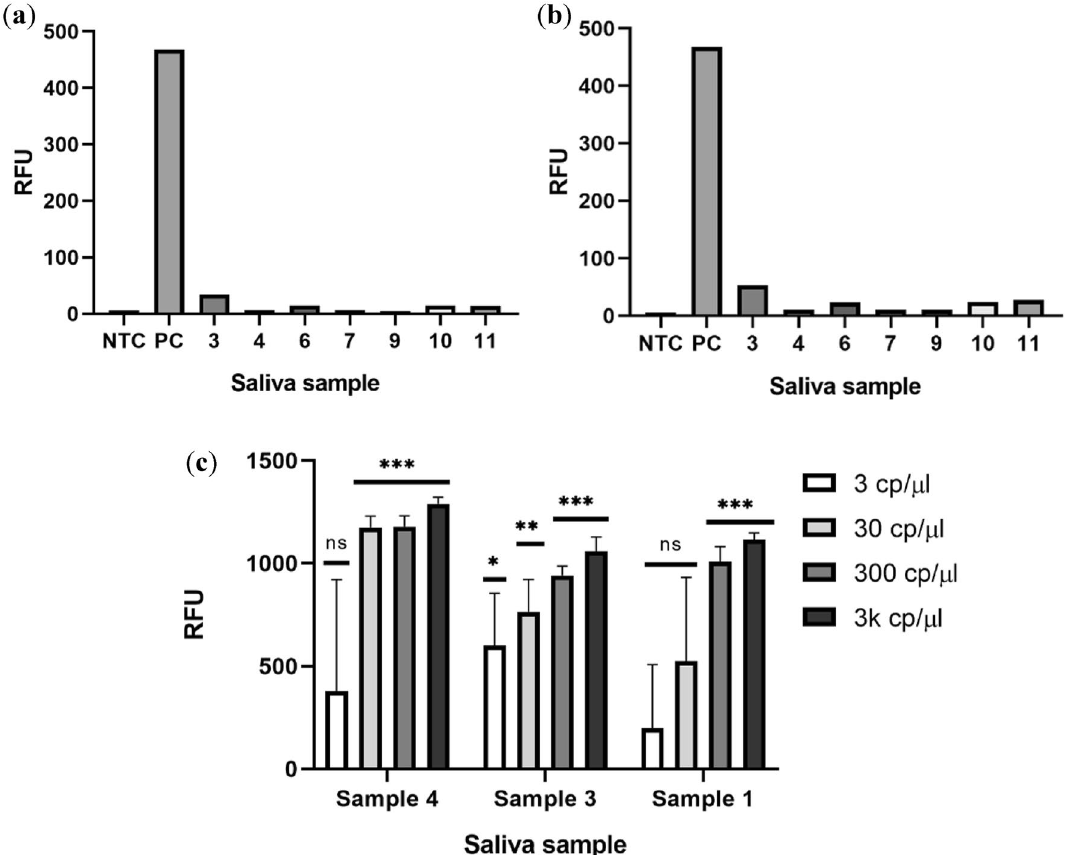
Figure 7. Inactivation of nucleases in saliva samples and limit of detection of spiked samples. RnaseAlert substrate nuclease detection system reaction for the different saliva samples using the SHINE buffer ( a ) and the Tween-20 buffer ( b ) in a 1:1 proportion. ( c ) End-point fluorescence signal in the Cas12a-mixture of spiked saliva samples processed using the SHINE buffer. Statistical significance was determined by unpaired